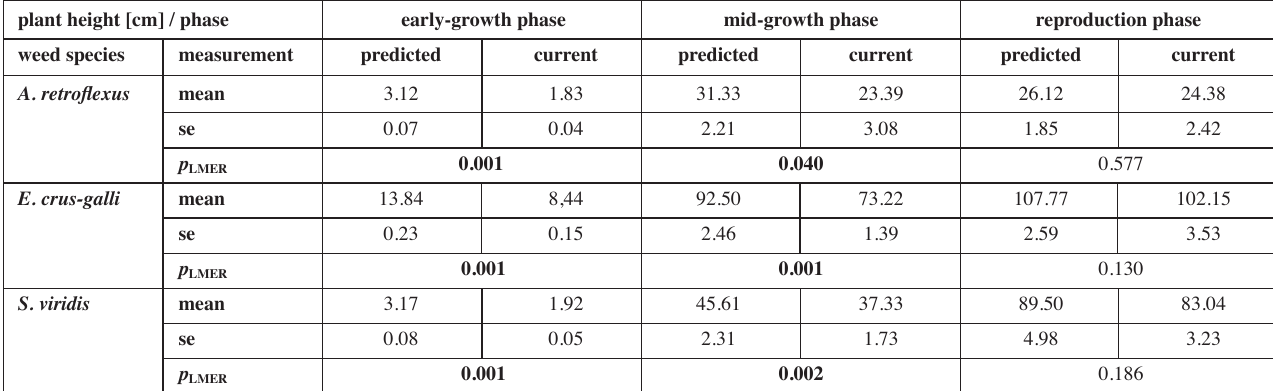
Tab. 2: Comparison of the influence of predicted future conditions on plant height [cm] at the end of early-growth phase , mid-growth phase and reproduc - tion phase of plants grown in pots for the three replications, mean and standard error (se) are given for predicted future and current climate, significant p LMER -values are bold.